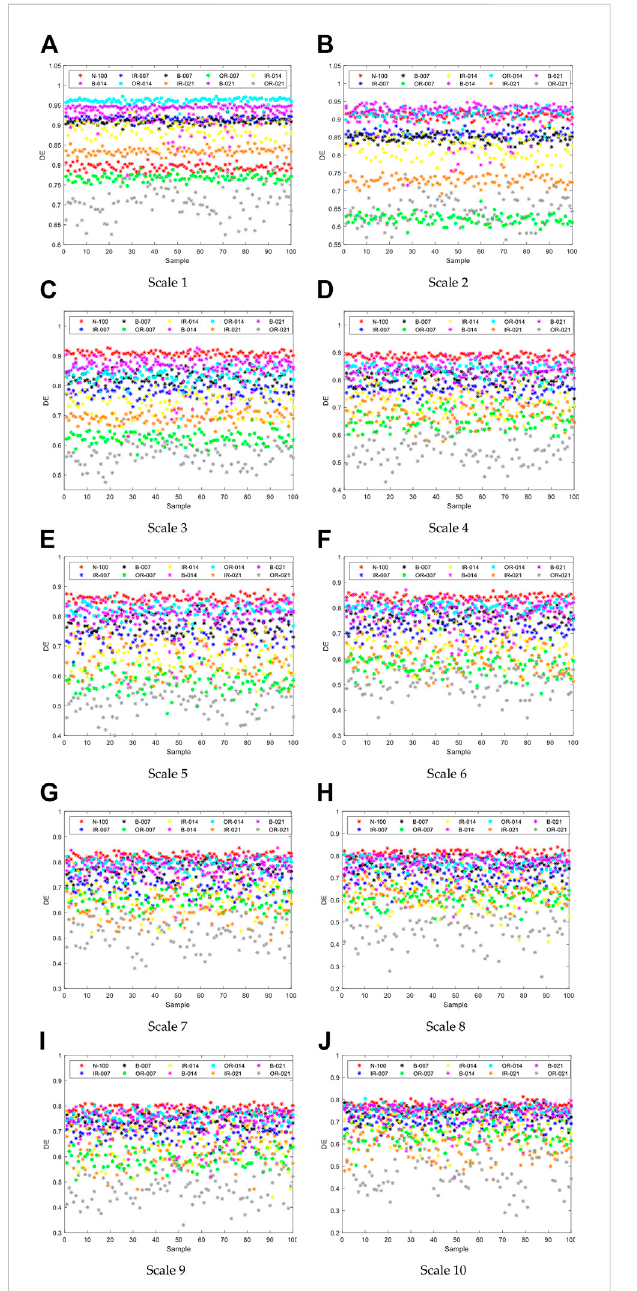
FIGURE 3 SinglefeaturedistributionoftenscalesofMDEfortensignals: (A- J) represent Scale 1 to Scale10.